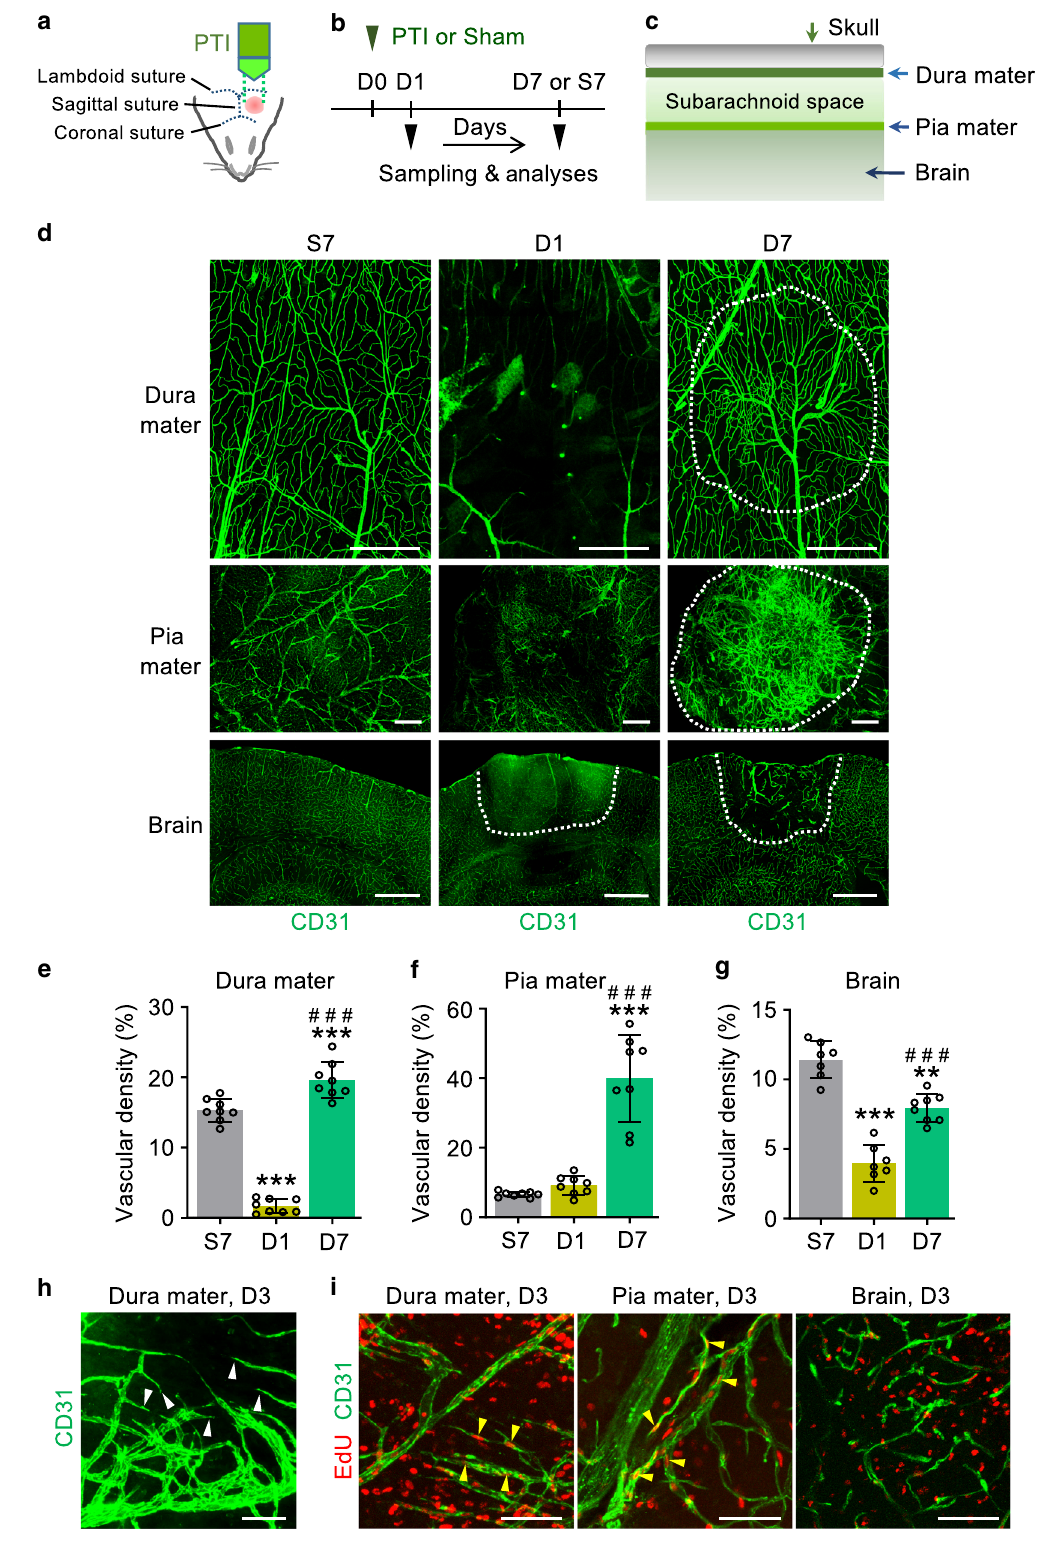
(Supplementary Fig. 5a – e), con fi rming that VEGFR2 signaling is critical for complete vascular regeneration in the injured dura mater. VEGFR2 signaling inhibition also suppressed vascular leakage in the brain by 44% with DC 101